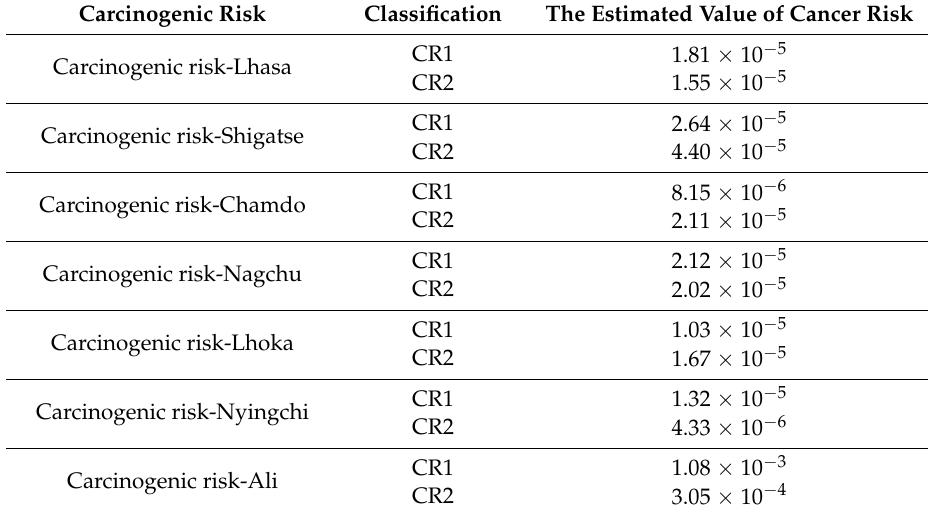
Table 4. The carcinogenic risks of Arsenic in natural waters of Tibet’s different